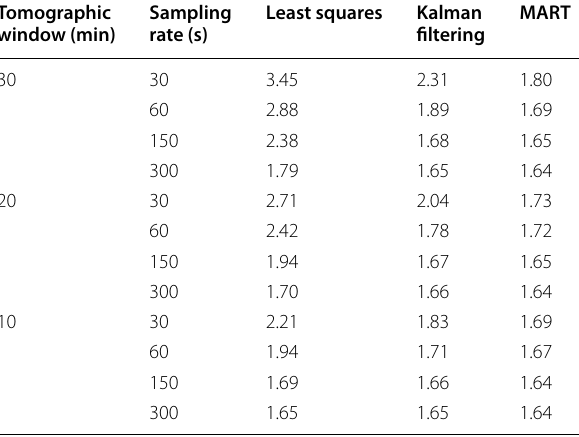
Table 2 Mean RMSE of WVD for the three tomographic methods in different schemes (g/m 3